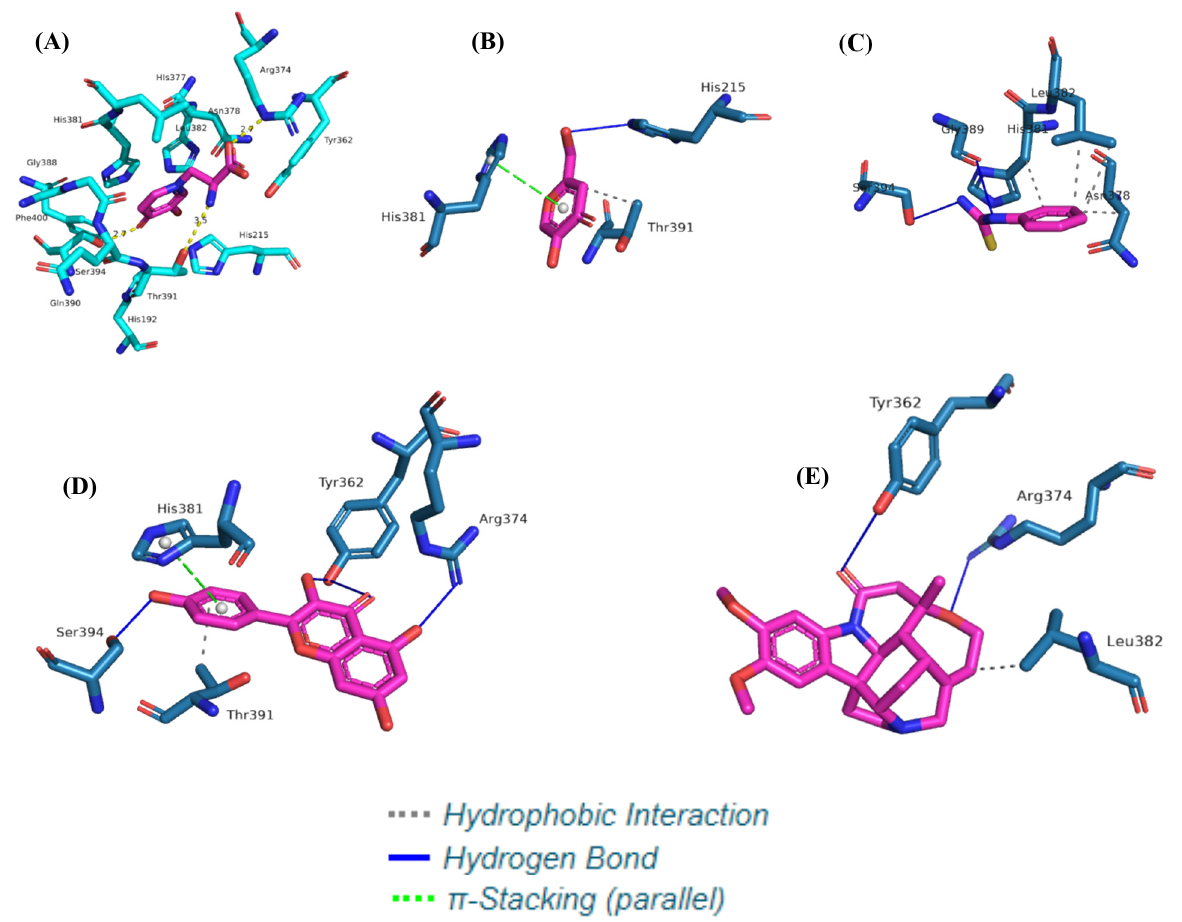
Figure 9. Hydrogen bonding or lipophilic interactions of positive controls MMS ( A ), kojic acid, ( B ) and PTU ( C ) and the secondary metabolites kaempferol ( D ) and brucine ( E ) identified in the extract (AM07AC) with the catalytic site of human tyrosinase. Table 2. Results of binding affinities and their main interactions at the human tyrosinase